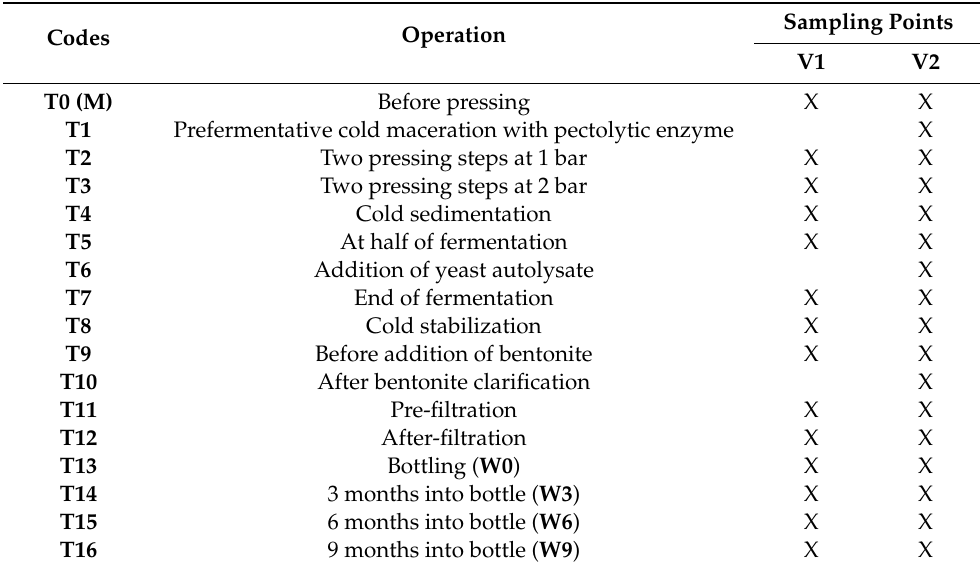
Table 1. Procedures applied for the